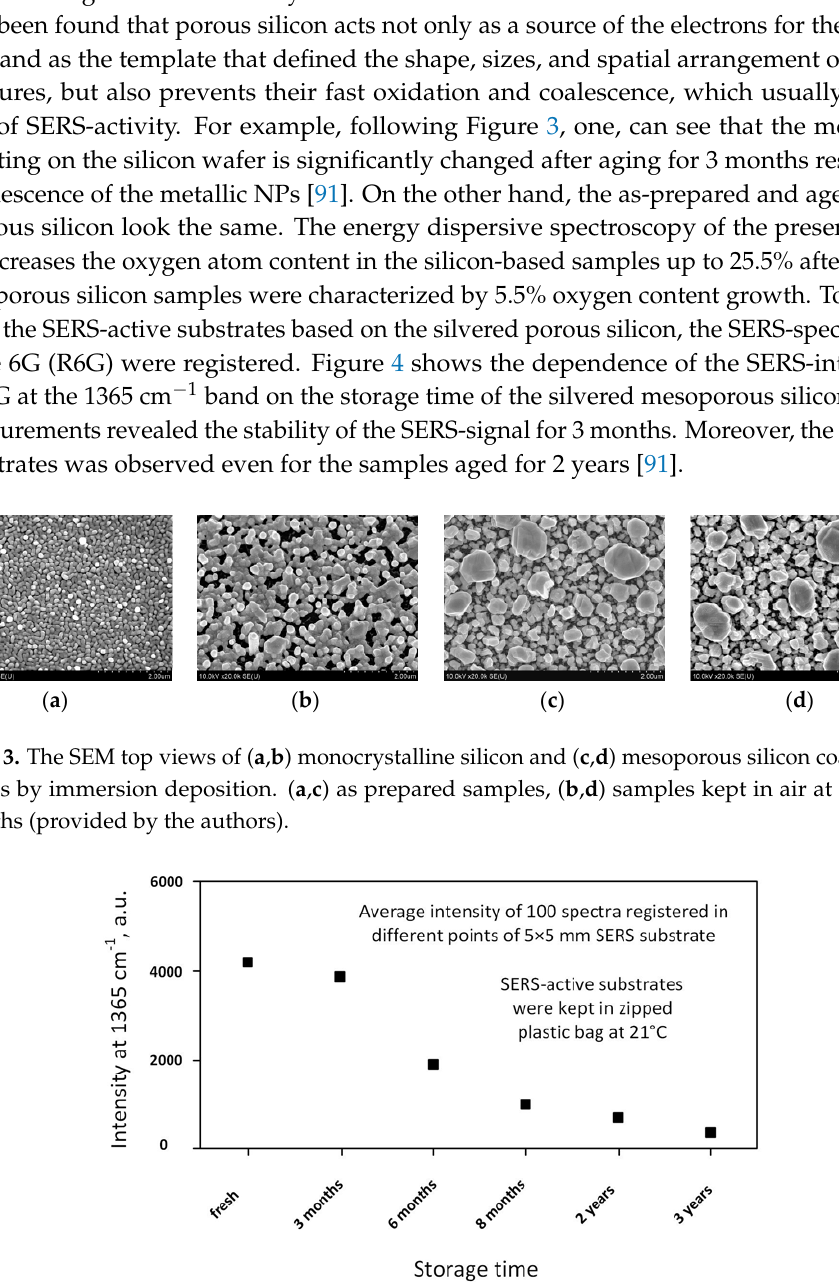
Figure 4. The SERS ‐ intensity of 10 − 6 M R6G at the 1365 cm − 1 band adsorbed on mesoporous silicon coated with Ag NPs by immersion deposition with a dependence on the time of the sample storage.